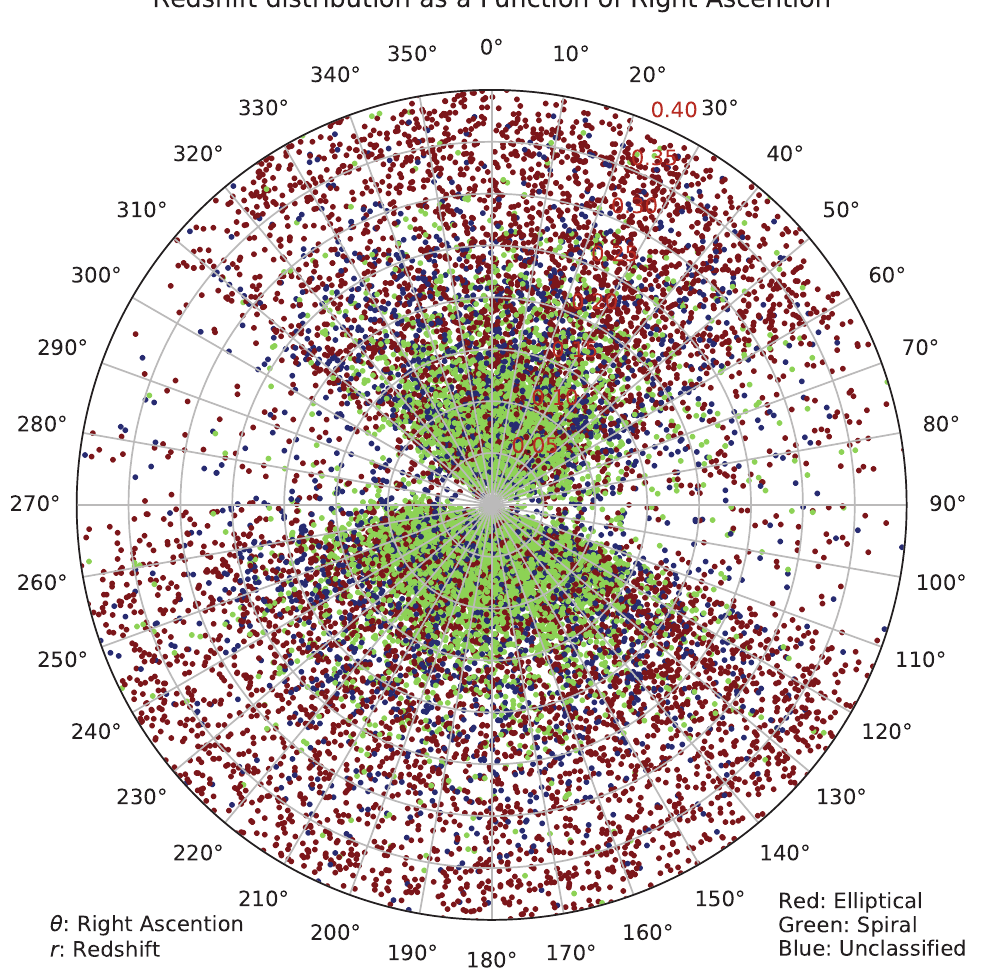
Figure 11. Distribution of spiral and elliptical galaxies by photometric redshift and right